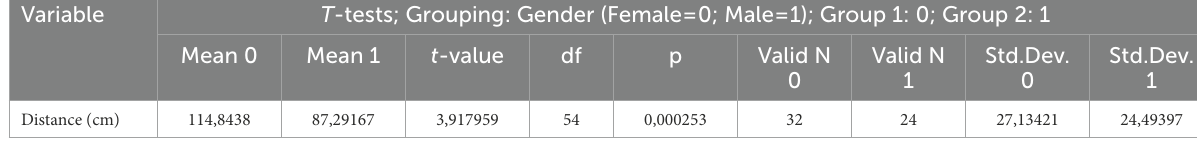
TABLE 3 Influence of gender on communication distance.